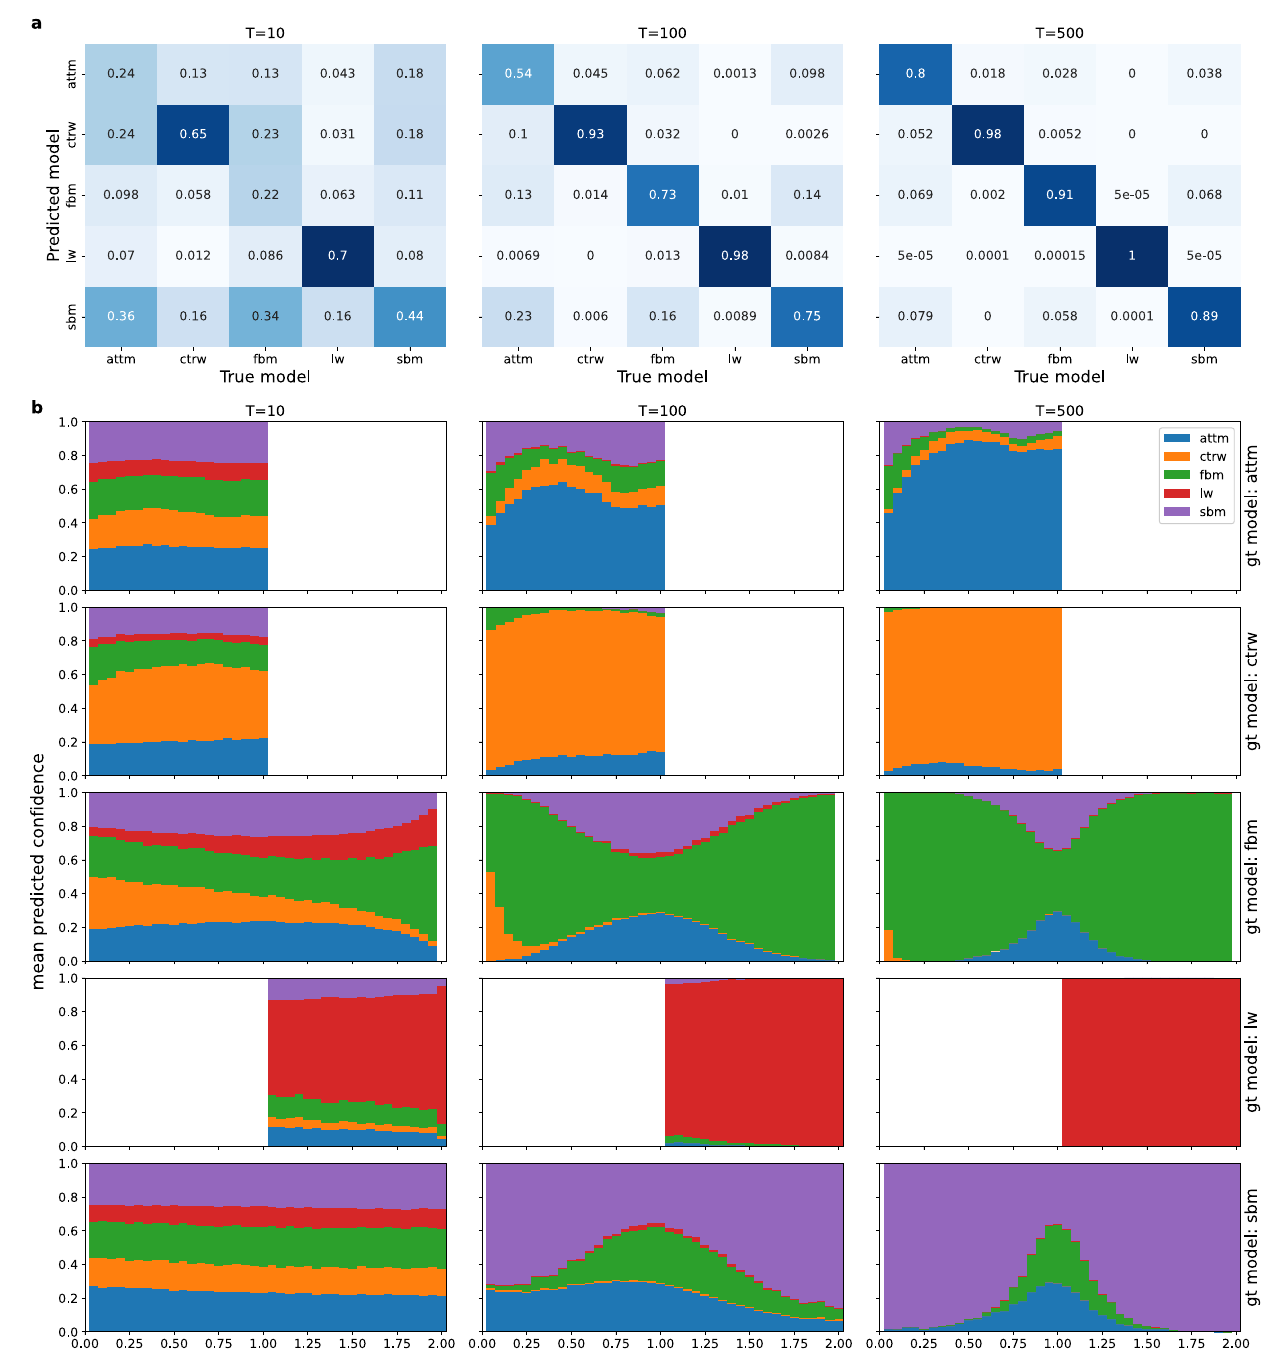
Fig.8|Analysisoftheclassi fi cationbehaviour.a Confusionmatricesfordifferent trajectorylengths.Theentriesindicatetherelativefrequencyofmodelpredictions (row) given a ground truth model (column).The matrices are obtained from Multi- SWAG predictions on a total of 10 5 test trajectories for each length. b Mean con- fi dences for different ground truth (gt) modelsin dependenceofthe ground truth